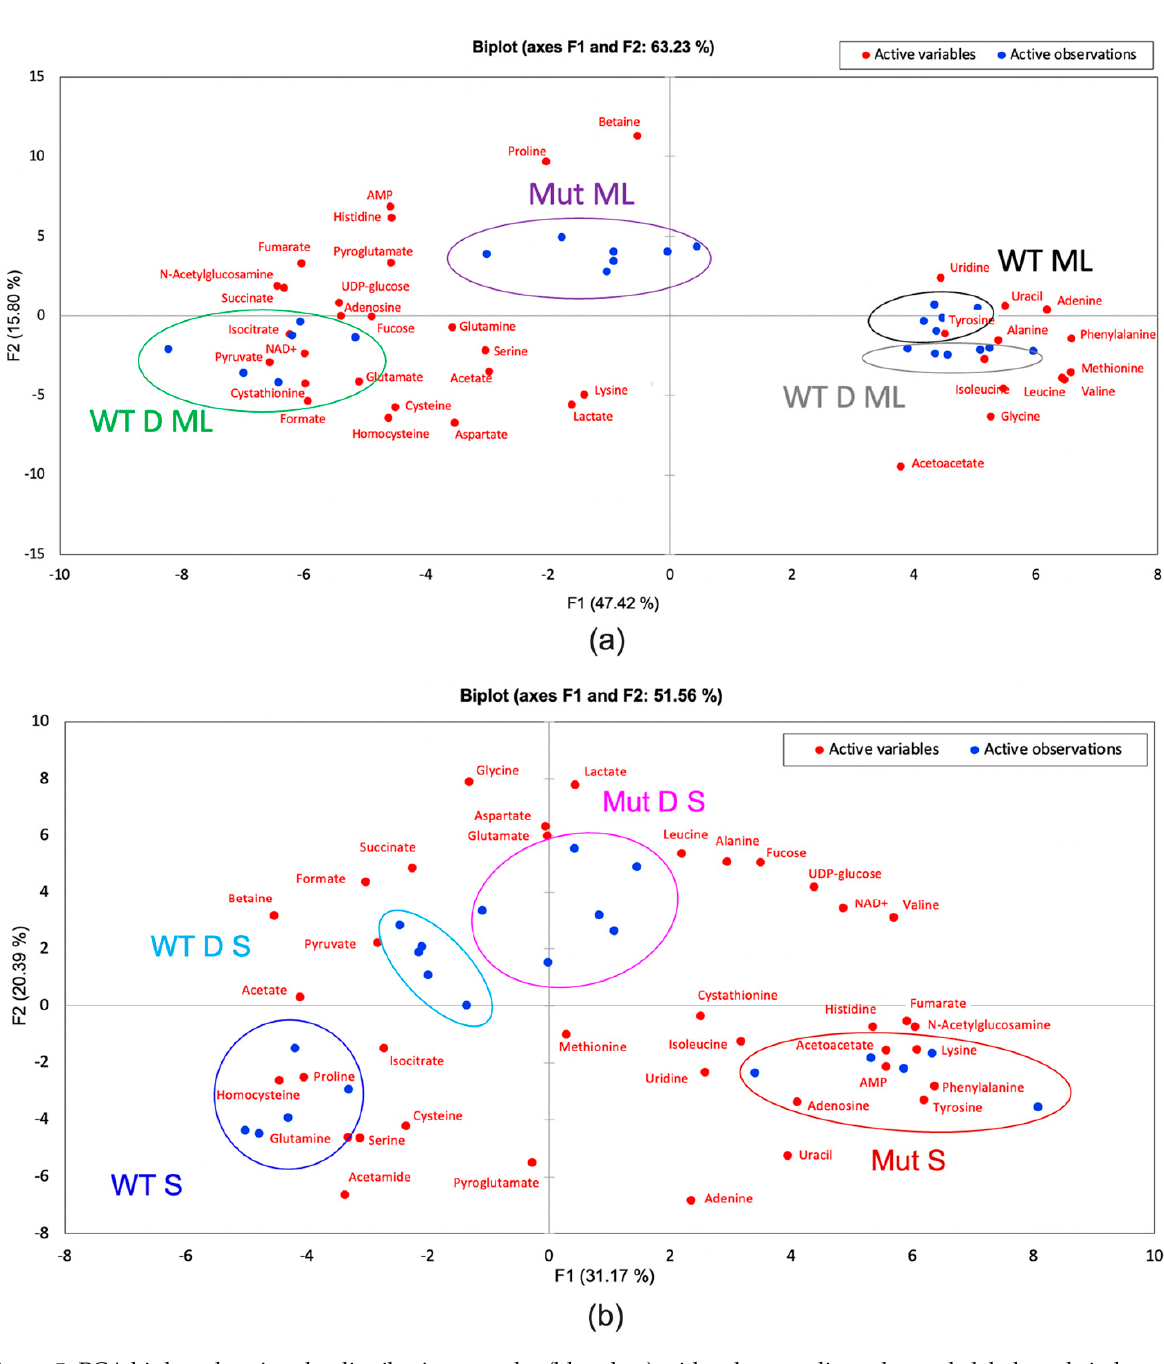
Figure 5. PCA biplots showing the distribution samples (blue dots) with color coordinated sample labels and circles and the distribution of metabolites (red dots). ( a ) Mid log phase samples showing WT ML and WT D ML very close together, Mut ML separated, and Mut D ML separated. ( b ) Stationary phase samples showing complete separation.